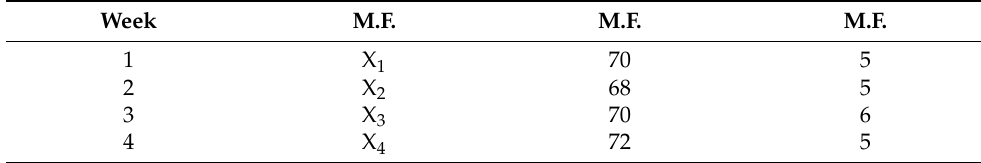
Table 1. A person’s perception of old age in 4 weeks.